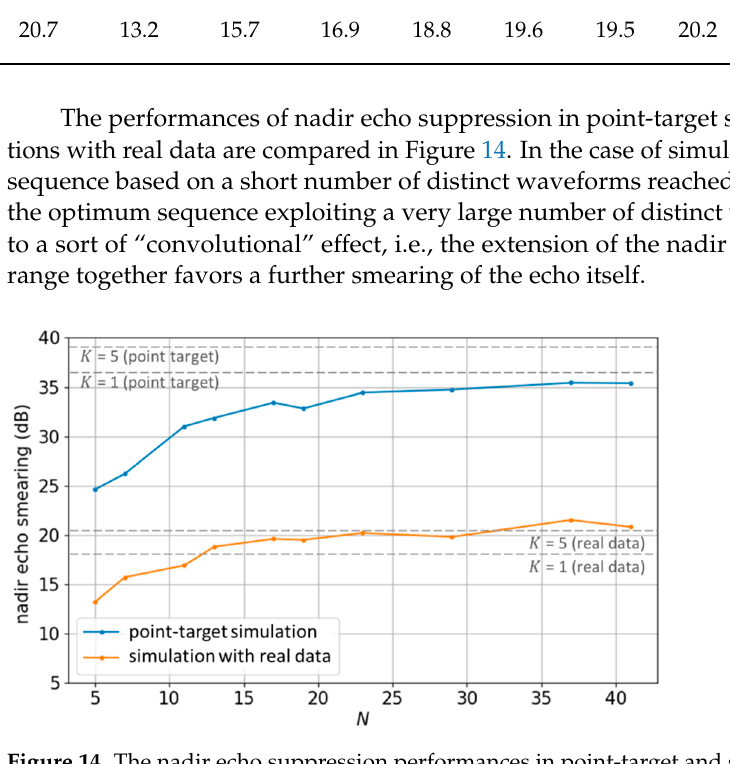
Figure 14. The nadir echo suppression performances in point-target and simulations with real data for various values of 𝑁 .